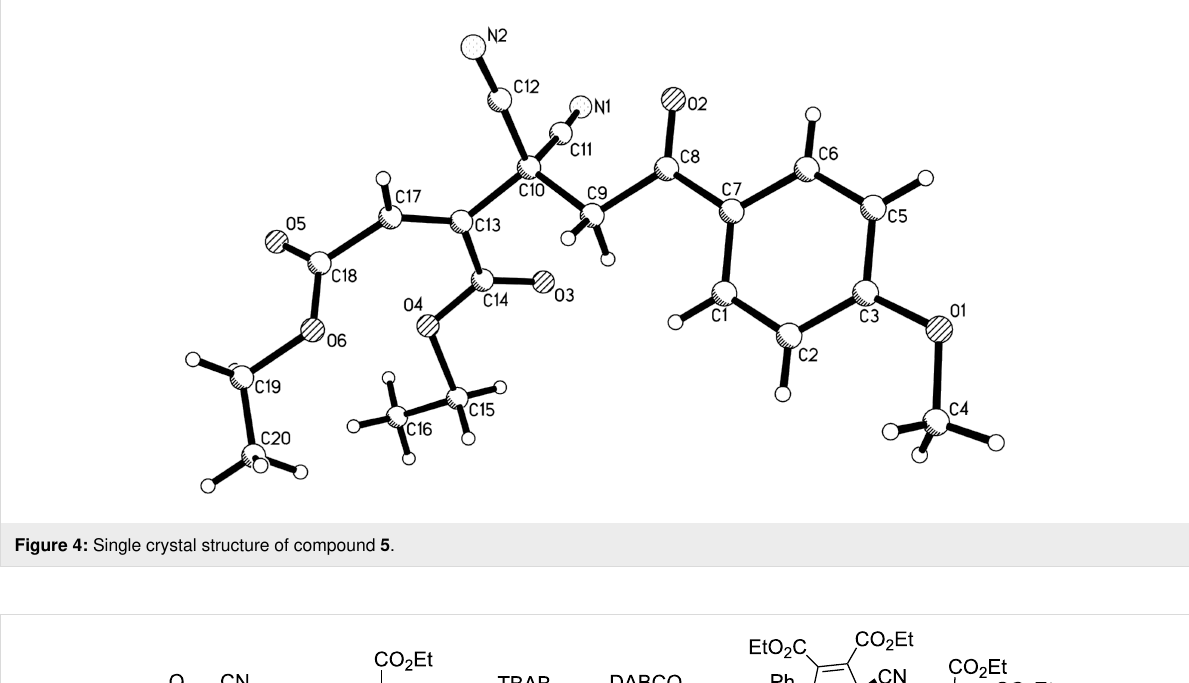
Figure 4: Single crystal structure of compound 5 .